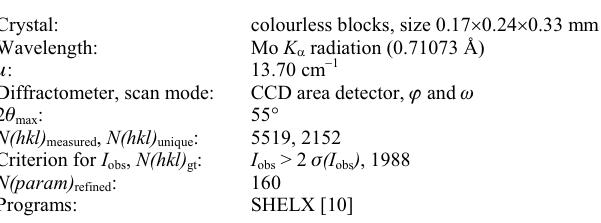
Table 1. Data collection and